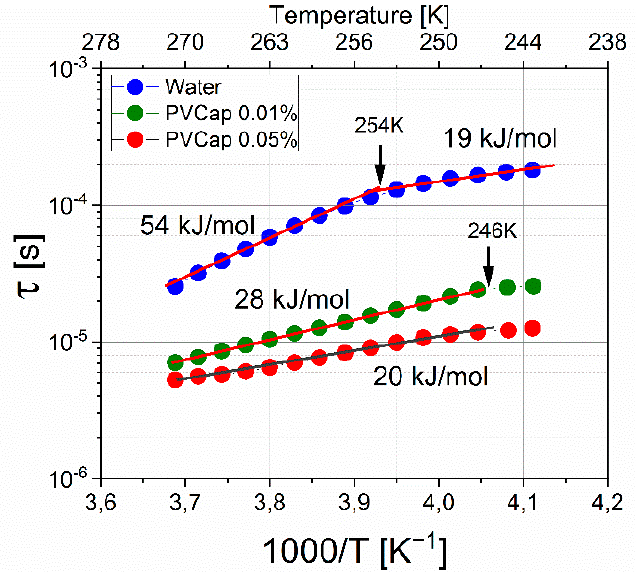
Figure 11. Relaxation time versus reciprocal temperature. Blue circles represent hydrate formed without the addition of an inhibitor; green circles represent hydrate formed with the addition of 0.01 wt. % PVCap; and red circles represent hydrate formed with the addition of 0.05 wt. % PVCap. The dependences ln ( τ )-(1000/T) have linear sections, which allows us to assume the activation mechanism of dielectric relaxation and, using the Arrhenius Equation (5), to estimate the activation energy ∆ E of the dielectric relaxation